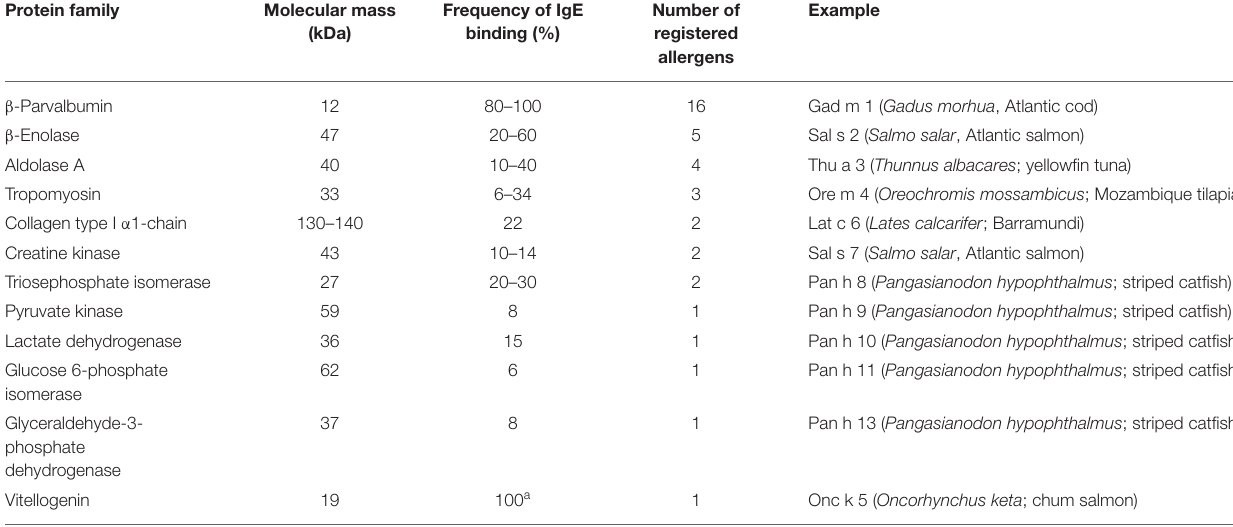
TABLE 2 | Families of fish allergens.